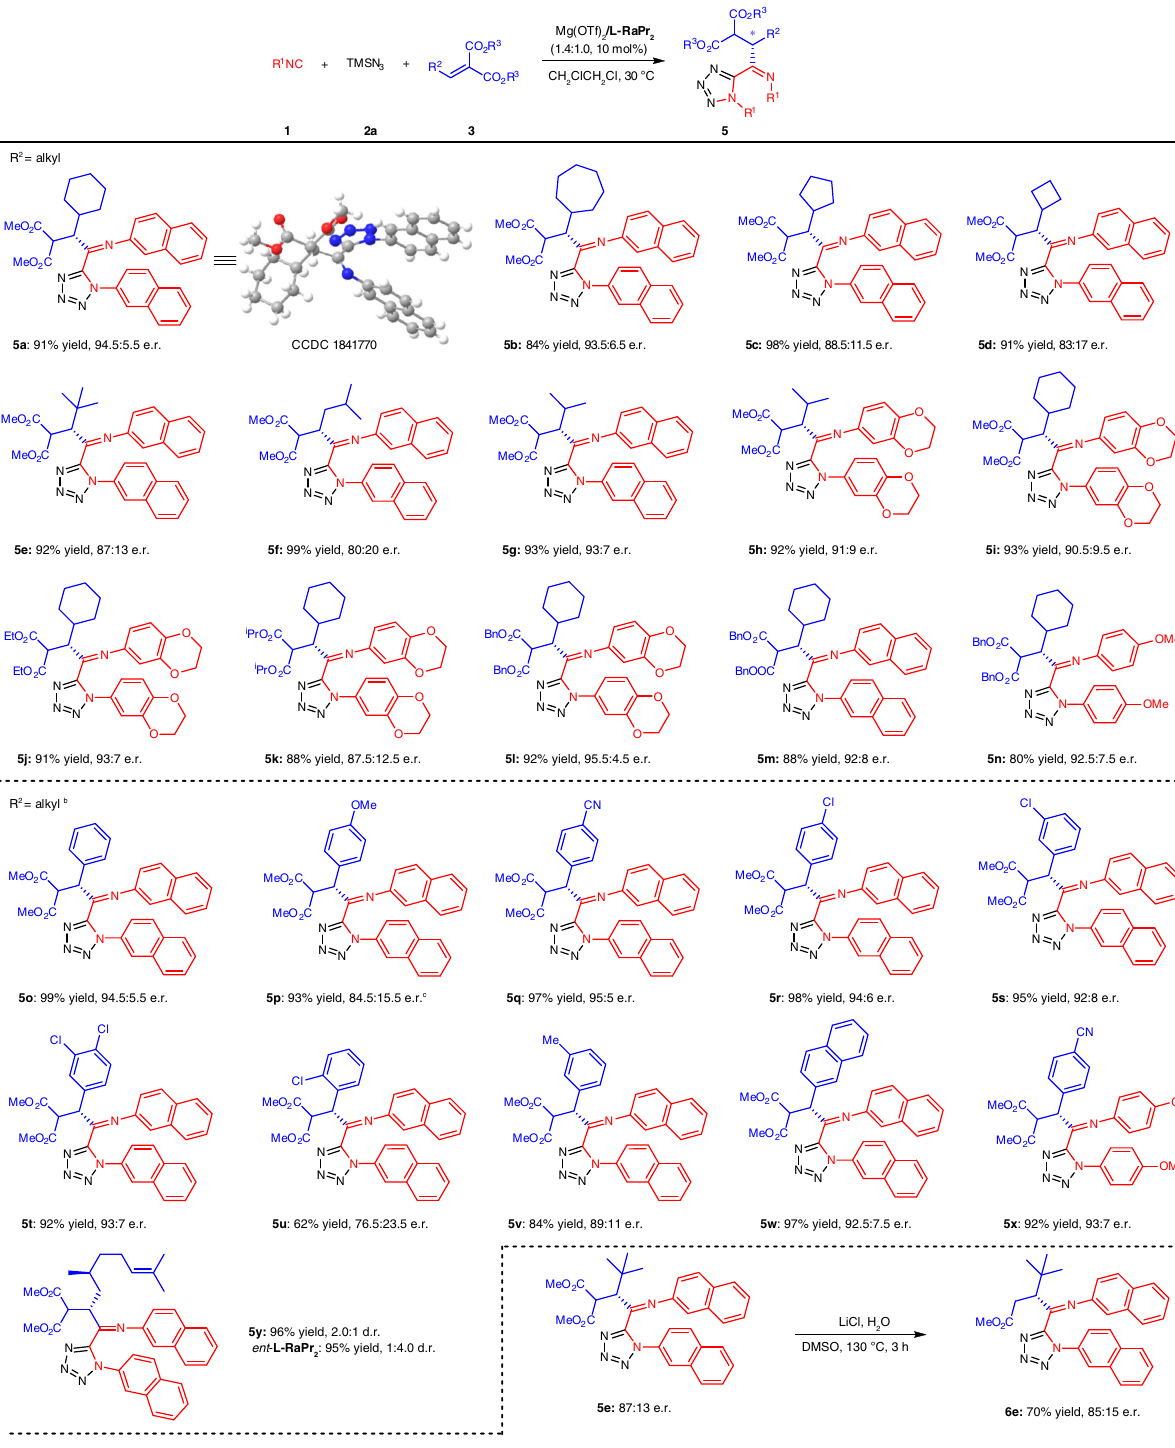
Fig. 3 Substrate scope of asymmetric synthesis four-component tetrazoles. Unless otherwise noted, all reactions were carried out with 1 (0.20 mmol), 2a (0.24 mmol), 3 (0.20 mmol), and Mg(OTf) 2 / L-RaPr 2 (1.4/1.0, 10 mol%) in CH 2 ClCH 2 Cl (1.0 mL) at 30 °C for 3 h. Isolated yield and e.r. was determined by CSP-HPLC analysis. b Carried out with 1 (0.20 mmol), 2a (0.20 mmol), 3 (0.15 mmol). c 20 mol% of NaBAr F 4 {sodium tetrakis[3,5-bis(tri fl uoromethyl) phenyl]borate} was corresponding products with good yields and high enantioselec- were suitable as well regardless of electronic nature of the sub- tivities ( 8a – 8h ; 79 – 93% yield, 92:8 – 97:3 e.r.). Comparatively, stitutions. The desired cycloaddition products ( 8i – 8p ) were iso- aliphatic aldehyde-derived alkylidene malonate was less ef fi cient, lated in excellent enantioselectivities (96:4 – 99:1 e.r.) with slightly yielding 8t in much lower yield and enantioselectivity (21% yield, lower yields (40 – 72%). Next, the screening of isocyanides implied 77:23 e.r.). On the other hand, other substituted isoquinolines that the steric hindrance exhibited a considerable effect on the e.r.